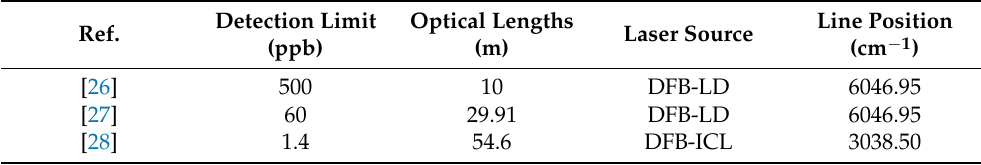
Table 2. Examples of the TDLAS-based CH 4 sensors.